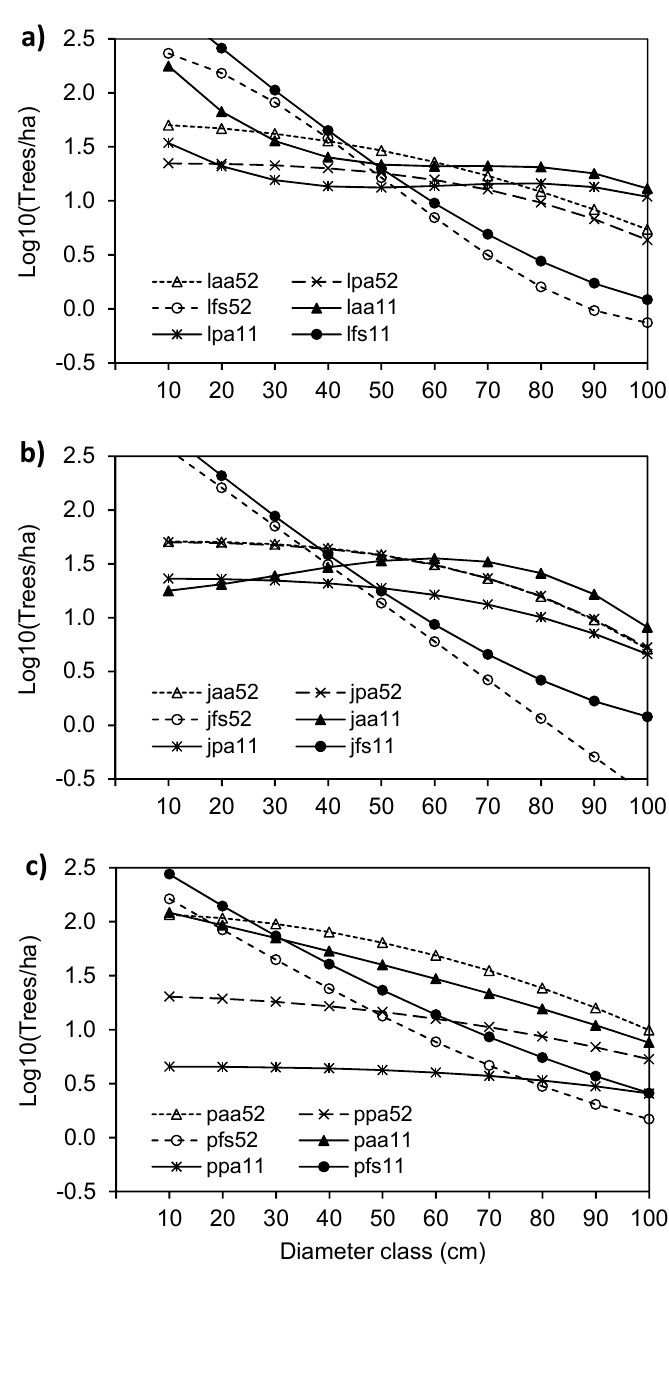
Figure A1. Temporal changes in species-specific diameter distributions of old-growth forests ( a ) Janj, ( b ) Lom, ( c ) Perucica. Curves and lines represent the best regression models. The first letter indicates old-growth forest (e.g., l denotes Lom), the next two letters represent Latin species names (e.g., aa denotes Abies alba ) and the following two numbers indicate the year of measurement (e.g., 11 denotes